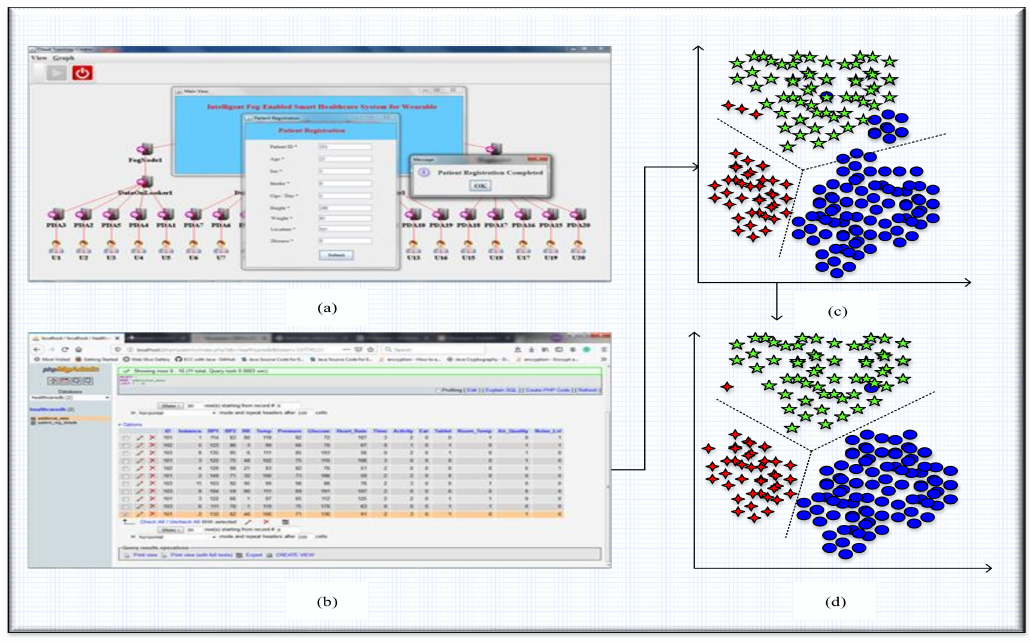
Figure 6. ( a ) User Registration in Tri-FogHealth, ( b ) Sample Data Generated, ( c ) Health Status Prediction (2L-2HMM), ( d ) Health Status Detection